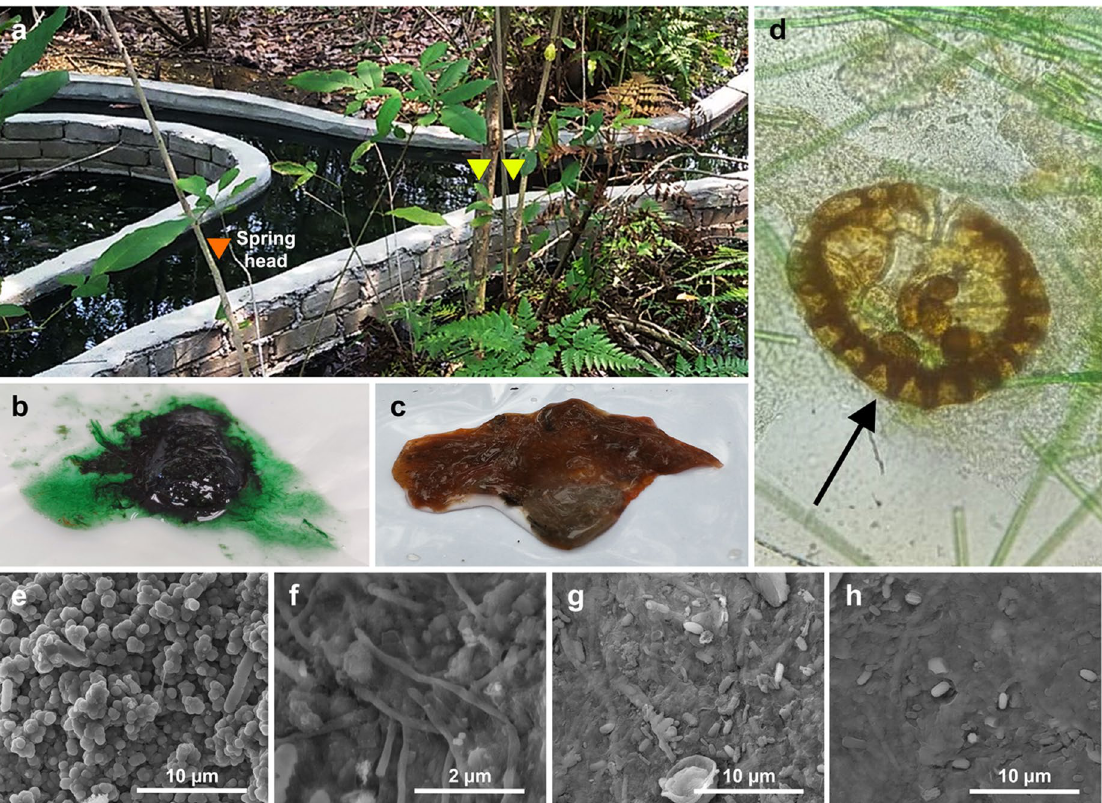
Figure 1. SKY hot spring. ( a ) SKY hot spring. Triangles indicate sampling sites. ( b ) Green microbial mat. ( c ) Brown microbial mat. ( d ) Light microscope (×400 magnification) of a green microbial mat. The sample contained filamentous microorganism and an unknown cell, putatively a eukaryote (indicated by an arrow). ( e , f ) Scanning electron microscope (SEM) images of green microbial mat. ( g , h ) SEM images of brown microbial